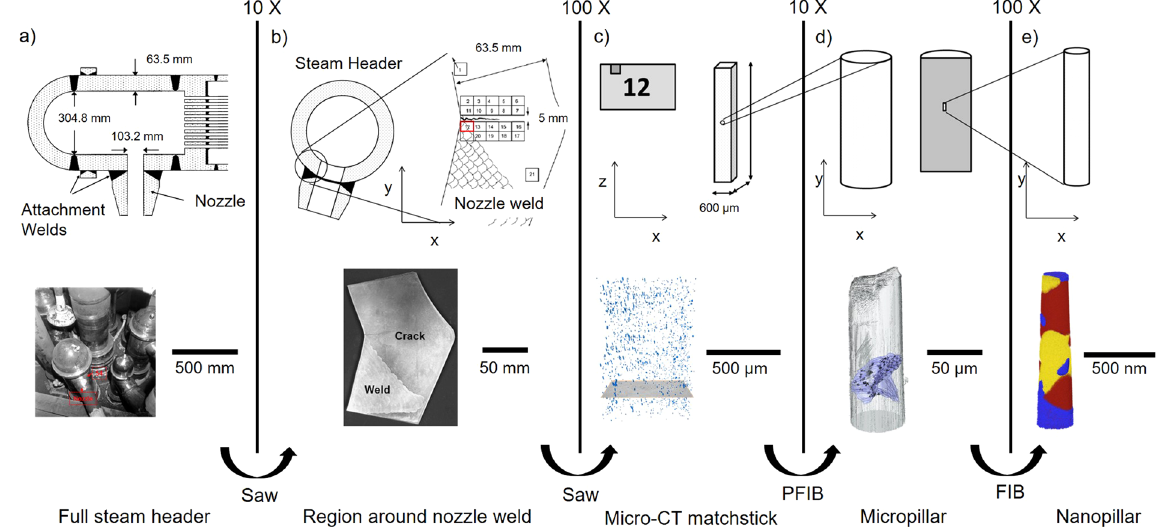
Figure 1. Illustration of the methodology applied in the study of a weld region of an AGR power station steam header, showing schematics and images of ( a ) the full steam header, ( b ) a section cut from the